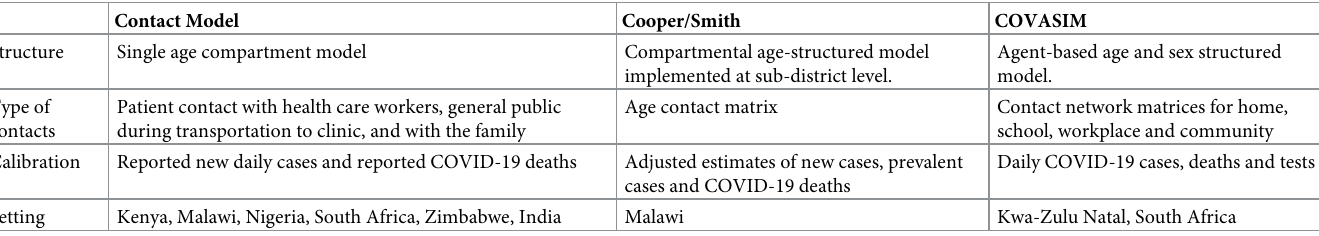
Table 2. Key characteristics of the COVID-19 models. Contact Model Structure Single age compartment model Compartmental age-structured model